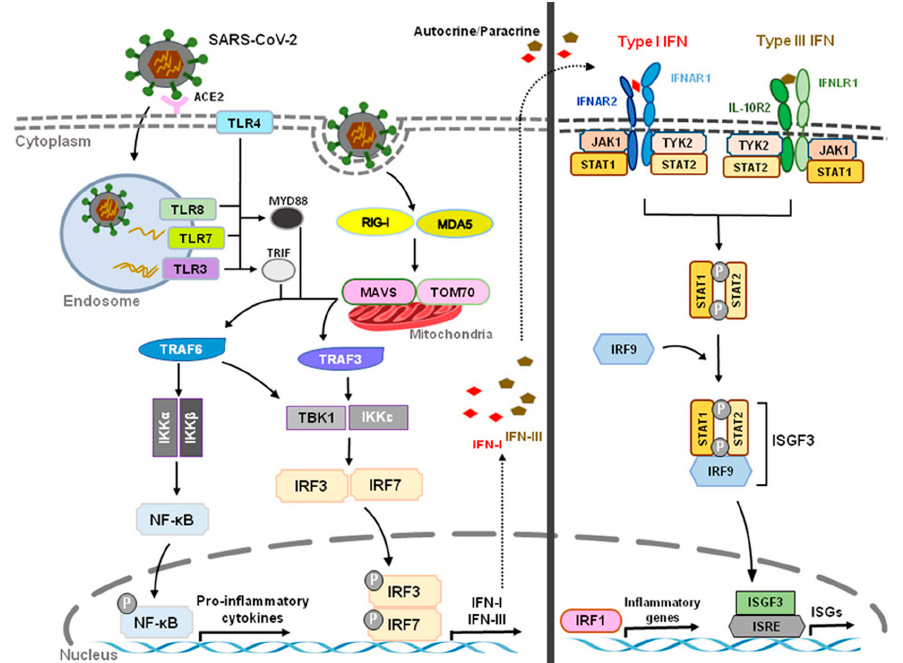
Figure 5. Innate Recognition and Interferon Signaling by Coronaviruses. Upon binding to angiotensin ‐ converting enzyme 2 (ACE2) and subsequent sensing of coronaviruses by various pathogen recognition receptors, including toll ‐ like receptors (TLRs) (TLR3, TLR4, TLR7, TLR8) and RIG ‐ I ‐ like receptors (RLRs) (RIG ‐ I, MDA5), activation of transcription factors nuclear factor ‐ kB (NF ‐ kB) and interferon regulatory factor 3 and 7 (IRF3, IRF7) stimulates the production of pro ‐ inflammatory cytokines and type I and III interferons (IFNs), respectively. The JAK/STAT signaling pathway is activated by IFNs through autocrine and paracrine secretion to induce the expression of IFN ‐ stimulated genes (ISGs). Type I IFNs and IFN III IFNs are both capable of inducing ISGs, but type I IFN signaling produces a stronger and faster response as well as inducing pro ‐ inflammatory cytokines and chemokines. However, delayed IFN ‐ I responses not only fail to control SARS ‐ CoV ‐ 2 virus but can also cause chronic inflammation and tissue damage.